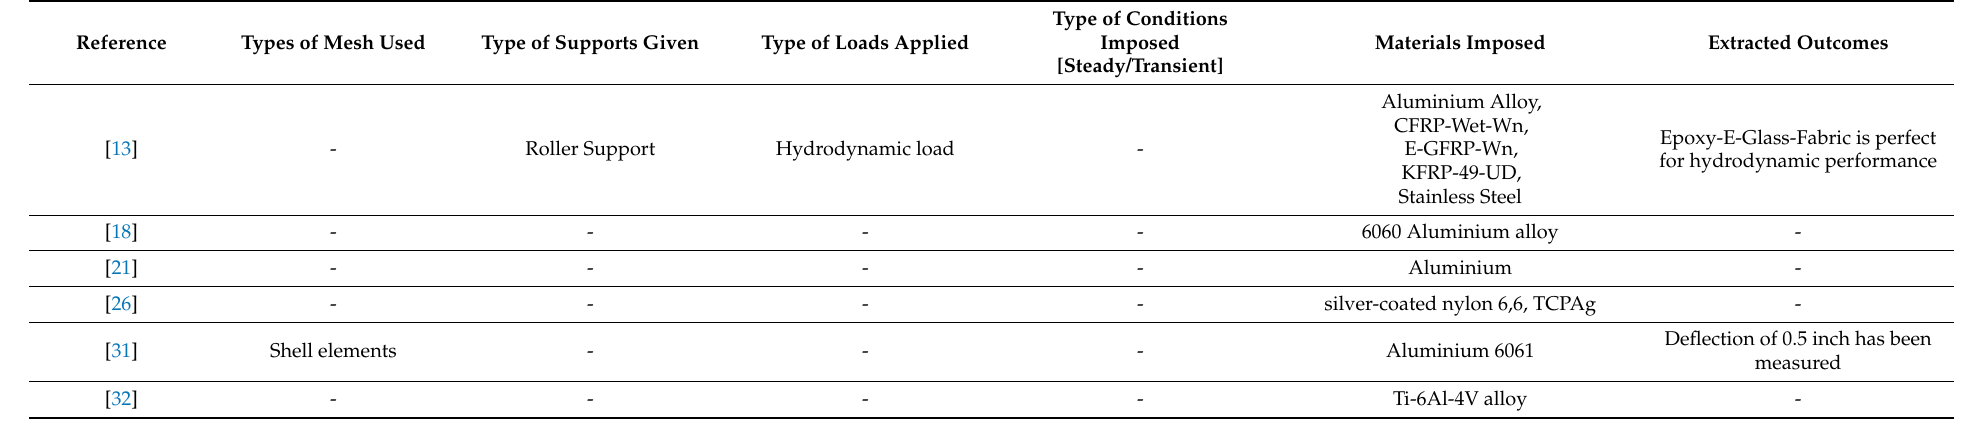
Table 3. Comparative information about parameters of FEA analysis on unmanned underwater vehicles.